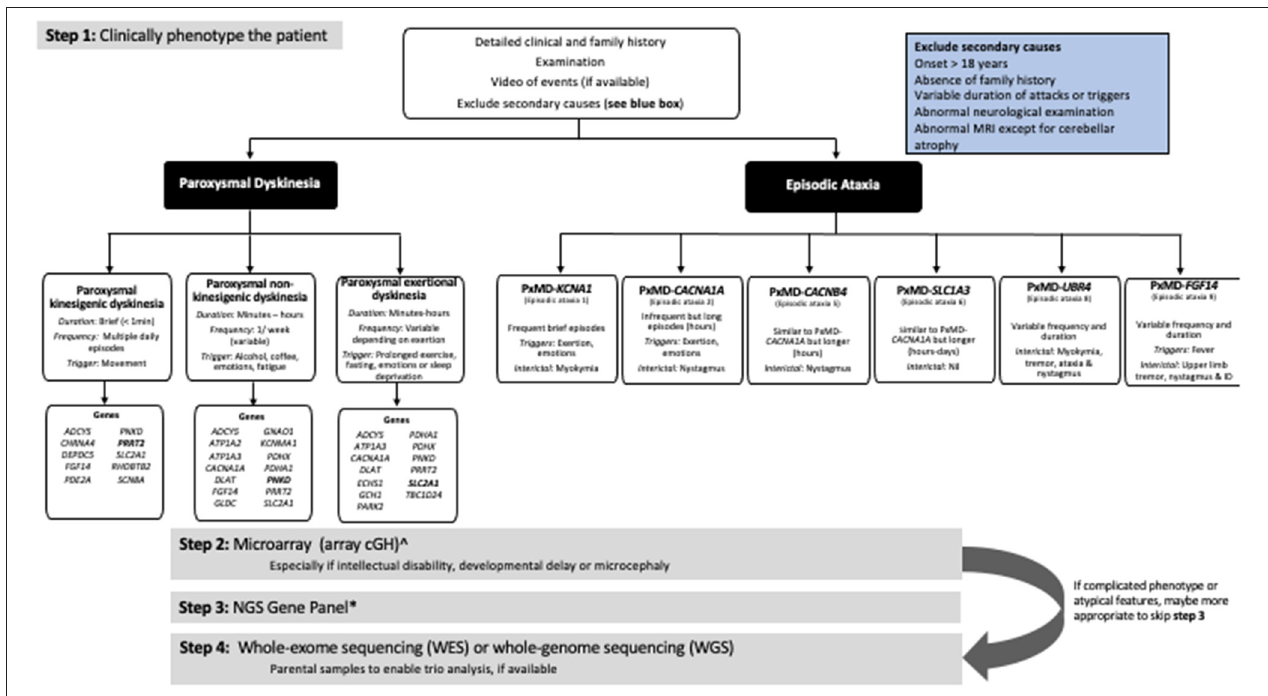
FIGURE 1 | Approach to the genetic investigation of paroxysmal movement disorders. ∧ Will not be required if using whole-genome sequencing. *The number of genes varies depending on the NGS panel used. Always check what genes are included in the